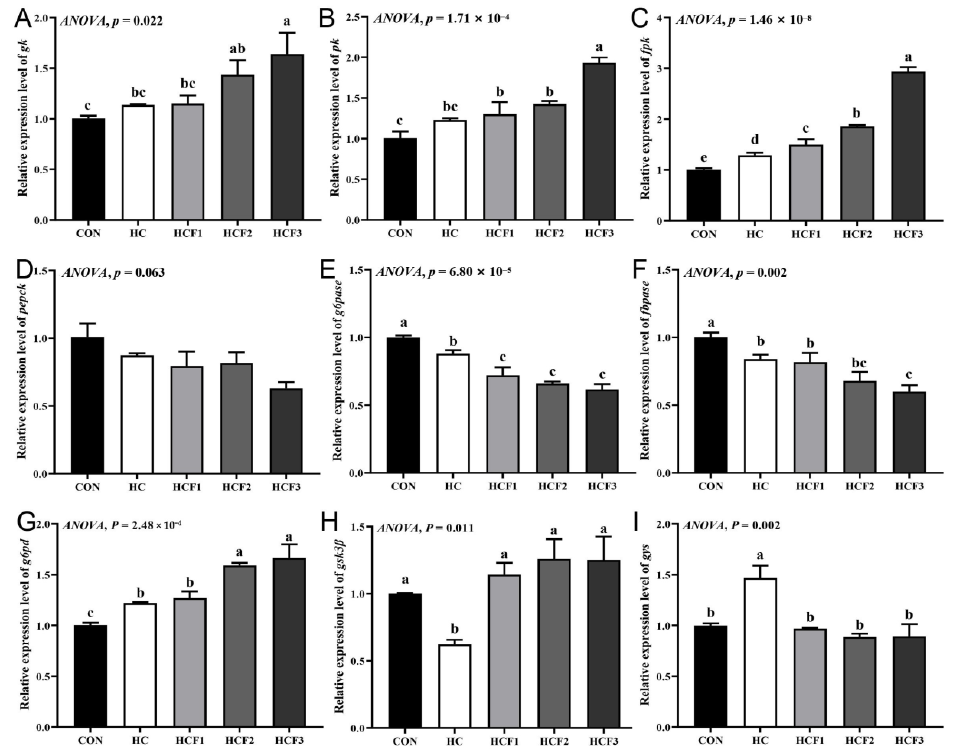
Figure 2. Influences of dietary mulberry leaf flavonoids on carbohydrate metabolism relative genes expression in liver in rice field eel fed on a high-carbohydrate diet. ( A ) gk ; ( B ) pk ; ( C ) fpk ; ( D ) pepck ; ( E ) g6pase ; ( F ) fbpase ; ( G ) g6pd ; ( H ) gsk3 β ; ( I ) gys . Different letters show significant difference ( p < 0.05).